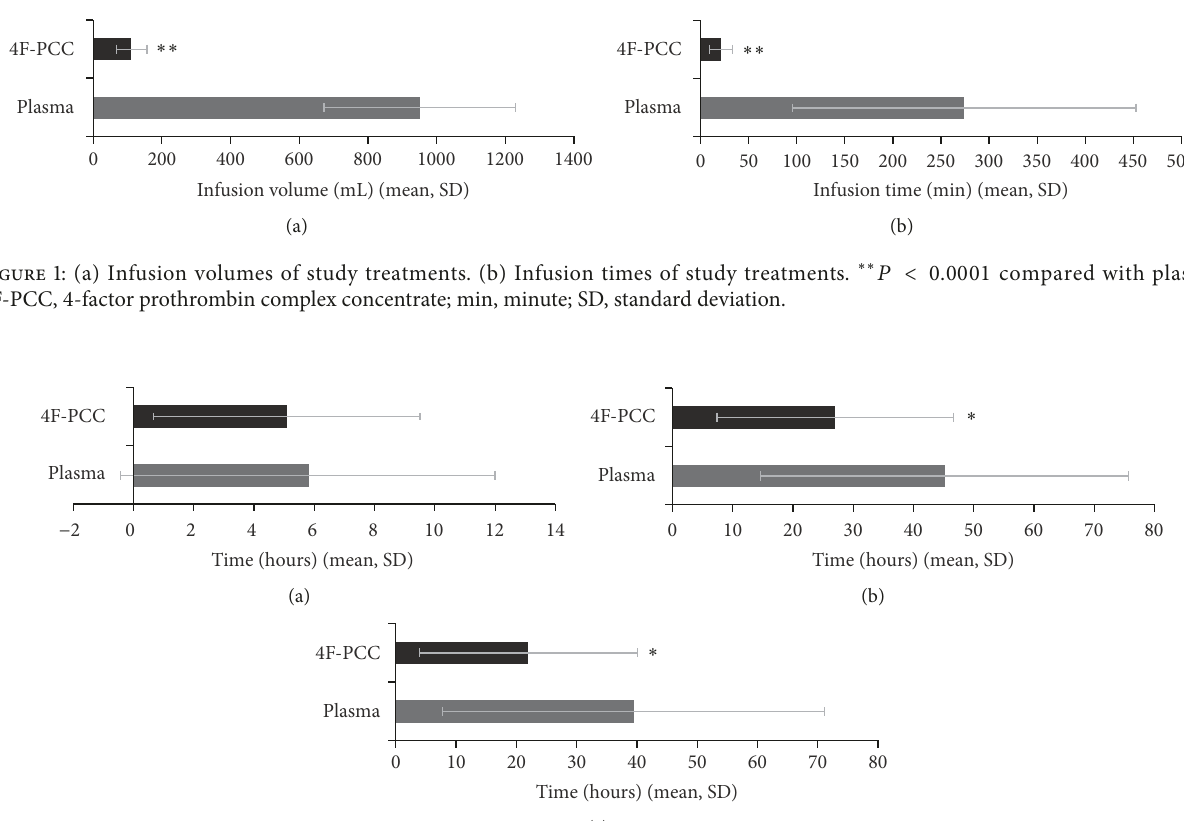
Table 3: Study treatment doses.